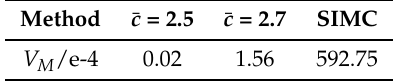
Table 2. Reference example (Example 2), i.e., an IPTD model, H p ( s ) = e − s settings for the MP parameters for Algorithm 1 and SIMC using the main performance objective V M (Equation (42)).